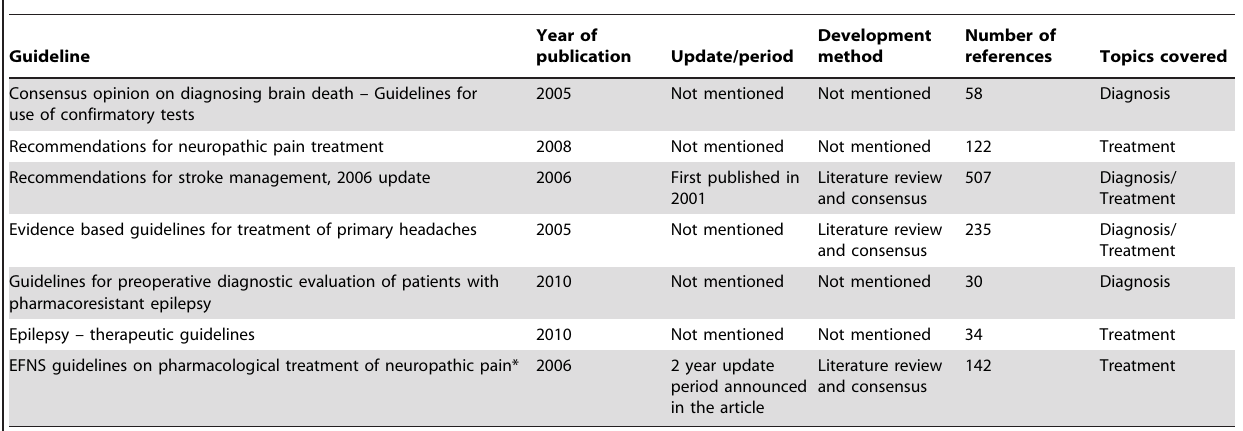
Table 1. Characteristics of Croatian neurology